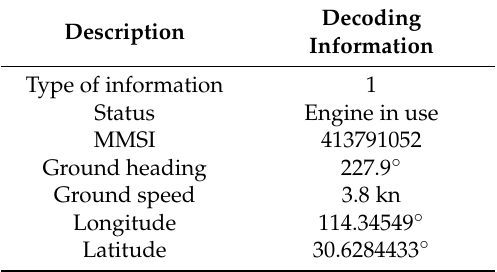
Table 2. The decoding results of the vessel’s dynamic information.